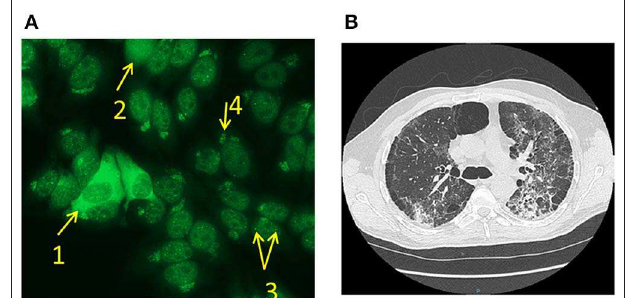
FIGURE 2 | (A) ANA aspect of Case #1. IIF on Hep-2 (1/80) revealed presence of rare isolated cytoplasmic islets (1), homogenous staining (2), multiple nuclear dots pattern (3) and anti-Golgi apparatus pattern (4). (B) Radiographic imaging of Case #2. Thoracic computed tomography scan revealed bilateral interstitial lung disease with lower lung predominance, thickened alveolar septa, condensations, and traction